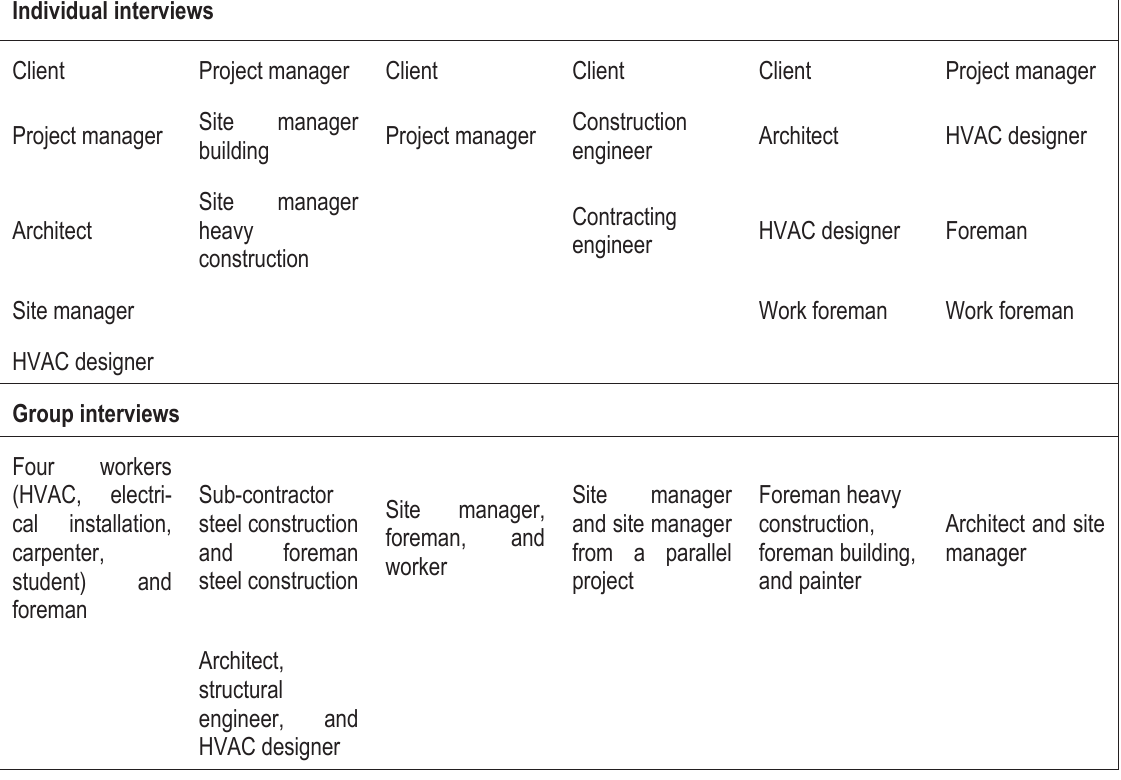
Table 2: Interview settings